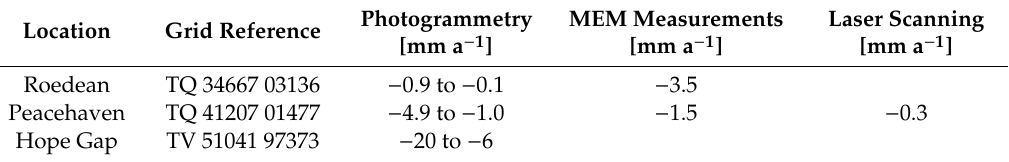
Table 1. Surface erosion comparison between different measurement methods. Data in the table collated in Dornbusch and Robinson